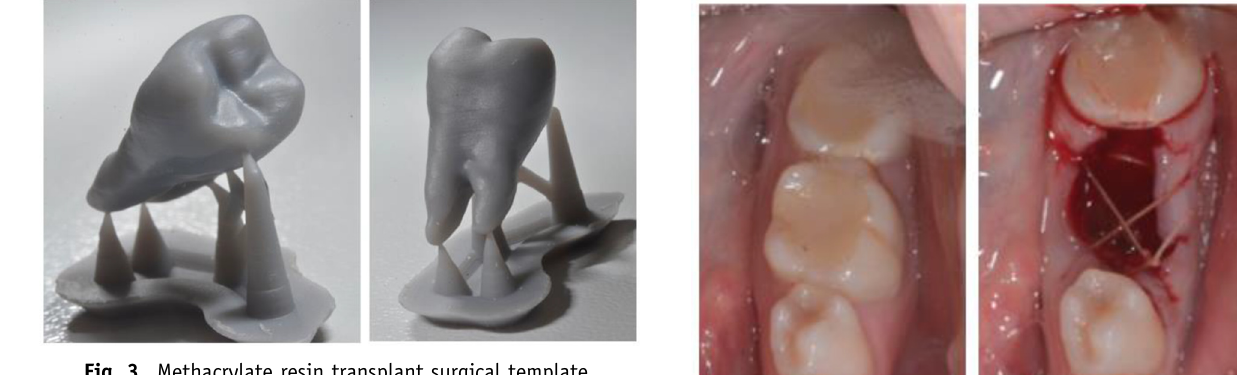
Fig. 3. Methacrylate resin transplant surgical template.